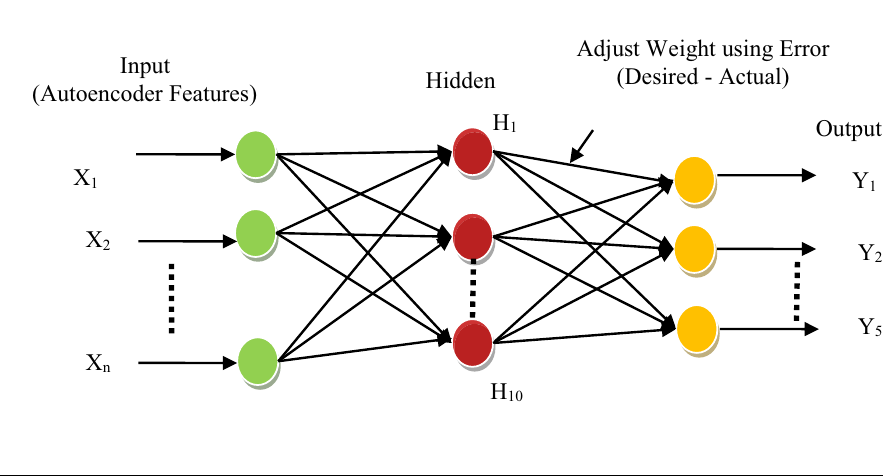
Fig. 5 Architecture of BPN for attack classification